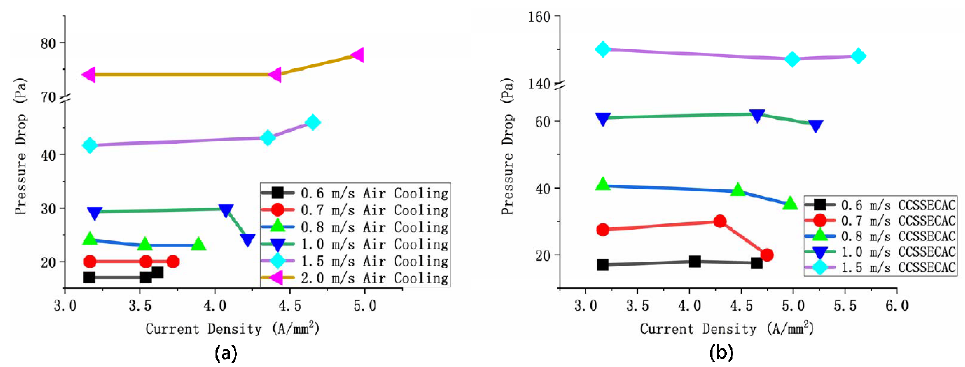
Figure 10. Airflow friction loss was not relevant to the heat load: ( a ) airflow friction loss in the air-cooling state and ( b ) airflow friction loss in the CCSSECAC state.